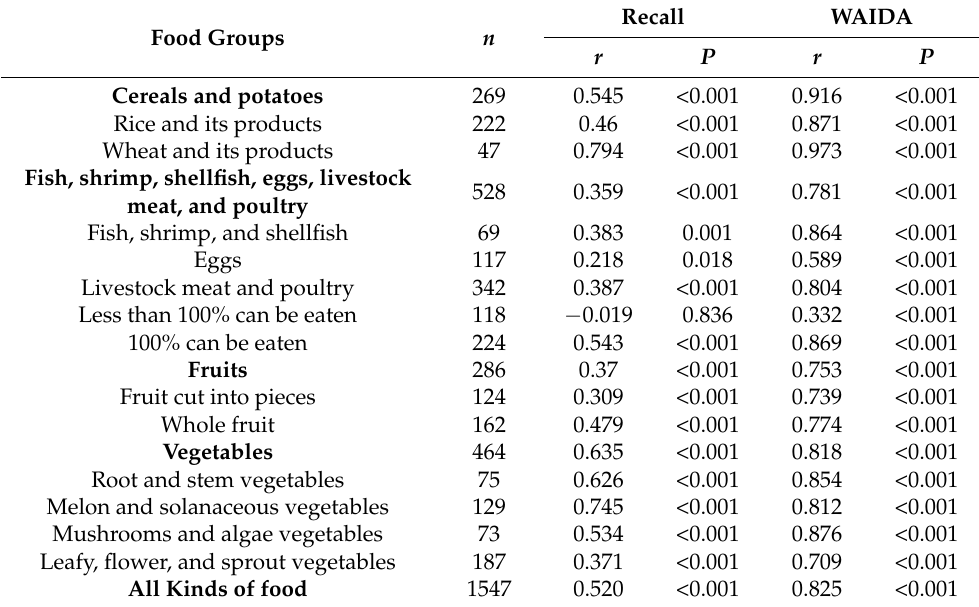
Table 2. Pearson correlation coefficients between the actual food weight and the food weight estimated by the recall or WAIDA